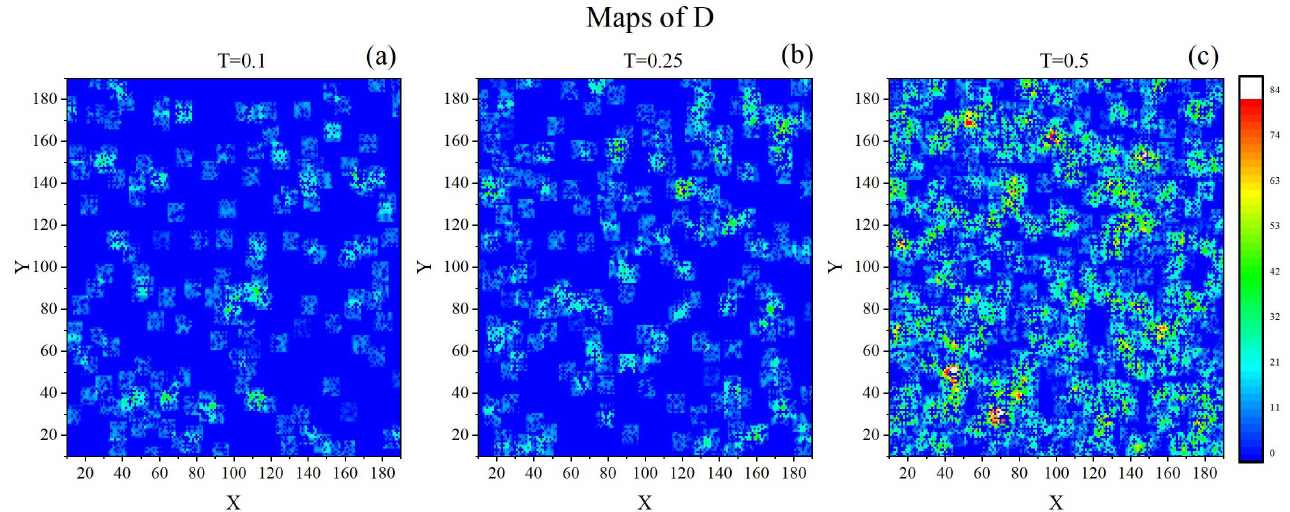
Figure 11. Instantaneous 2-dimensional maps of parameter D : T = 0.1 ( a ), T = 0.25 ( b ) and T = 0.5 ( c ).